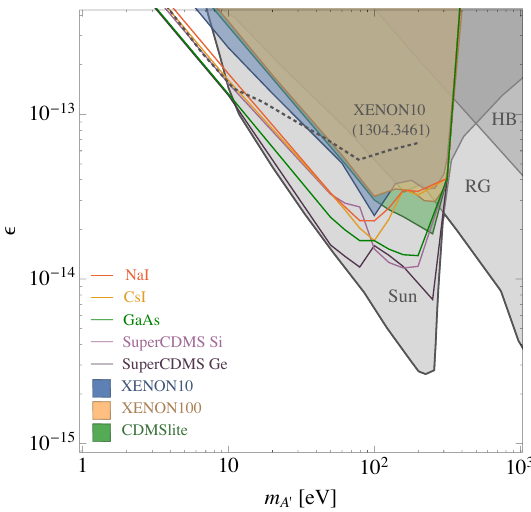
Figure 4 . Constraints ( shaded regions ) and prospective sensitivities ( solid colored lines ) for dark- photons ( A 0 ) with a St(cid:127)uckelberg mass from the Sun via resonant production (including in-medium e(cid:11)ects). Colored regions show constraints from XENON10, XENON100, and CDMSlite, as derived in this work. Deep- and light-purple solid lines show projected 90% C.L. sensitivities for Super- CDMS SNOLAB HV using either Ge (20 kg-years) or Si (10 kg-years) targets, respectively. Yellow , orange , and green solid lines show projected sensitivities for hypothetical experiments with the scintillating targets CsI, NaI, and GaAs, assuming an exposure of 10 kg-years. All projections as- sume a realistic background model discussed in the text, but zero dark counts to achieve sensitivity to low-energy electron recoils. Shaded gray regions show constraint from anomalous cooling of the Sun. Also shown ( dotted line ) is the bound derived in [66] based on XENON10 data